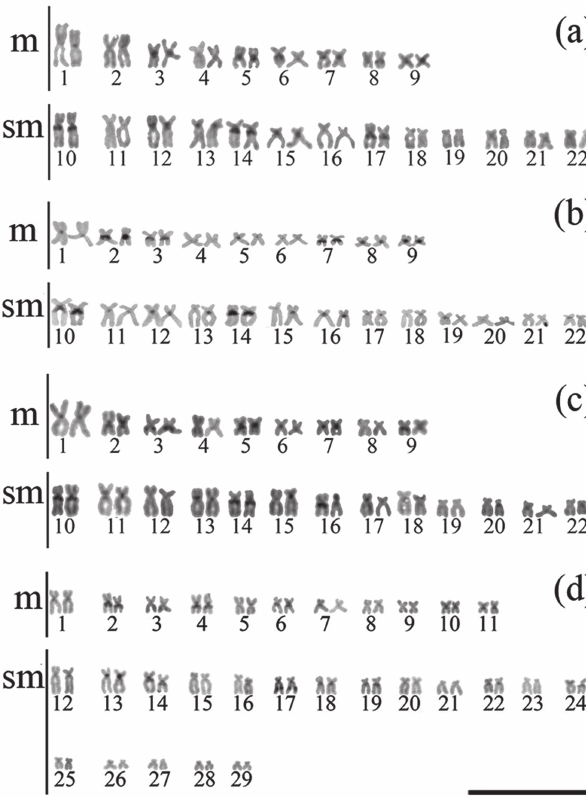
Fig. 2. Karyotypes of the Corydoras species subjected to C-banding: (a) C. ehrhardti (Verde River), (b) C. aff. paleatus (Iguaçu River), (c) C. aff. paleatus (Areia stream), and (d) C. lacrimostigmata (Barra Grande River). Scale bar = 10 μm.